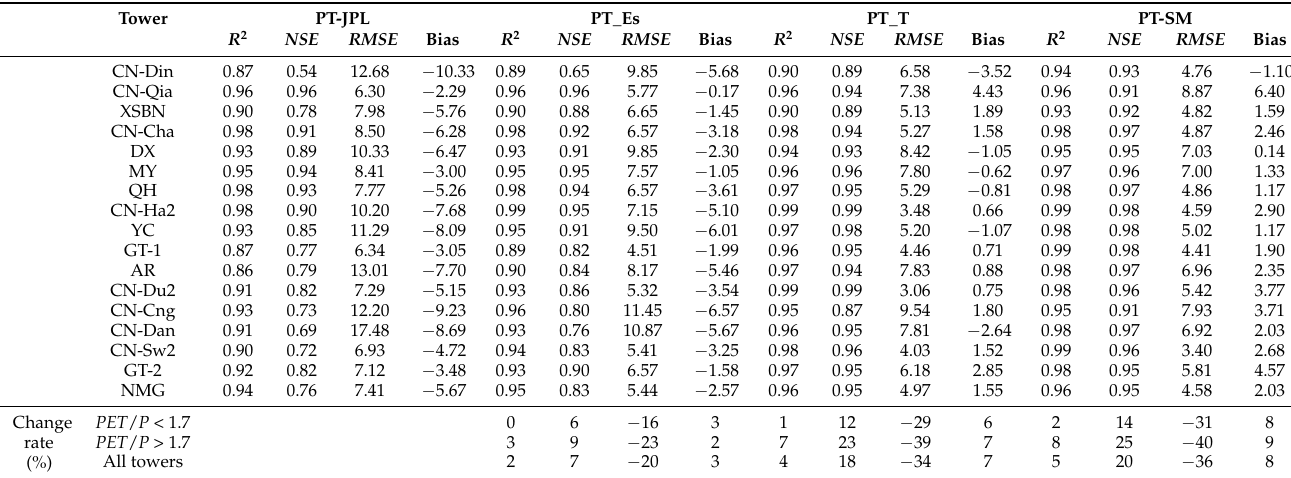
Table 3. Quantitative measures of original PT-JPL model, updated algorithm PT-SM with soil moisture incorporation into soil evaporation (PT_Es), updated algorithm with soil moisture incorporation into transpiration (PT_T), and updated PT-SM ET performance at monthly time-steps for 17 flux